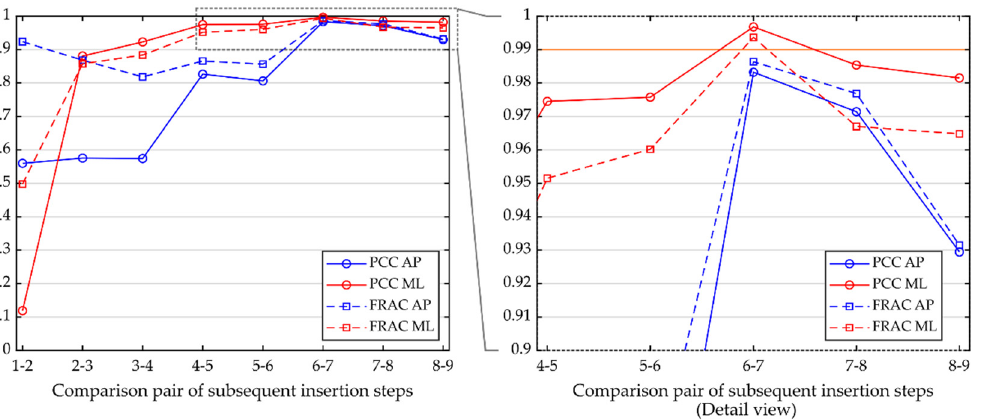
Figure A2. PCC and FRAC development for insertion with soft tissue. The PCC threshold (indicated in orange) is reached at the step 6–7 transition.